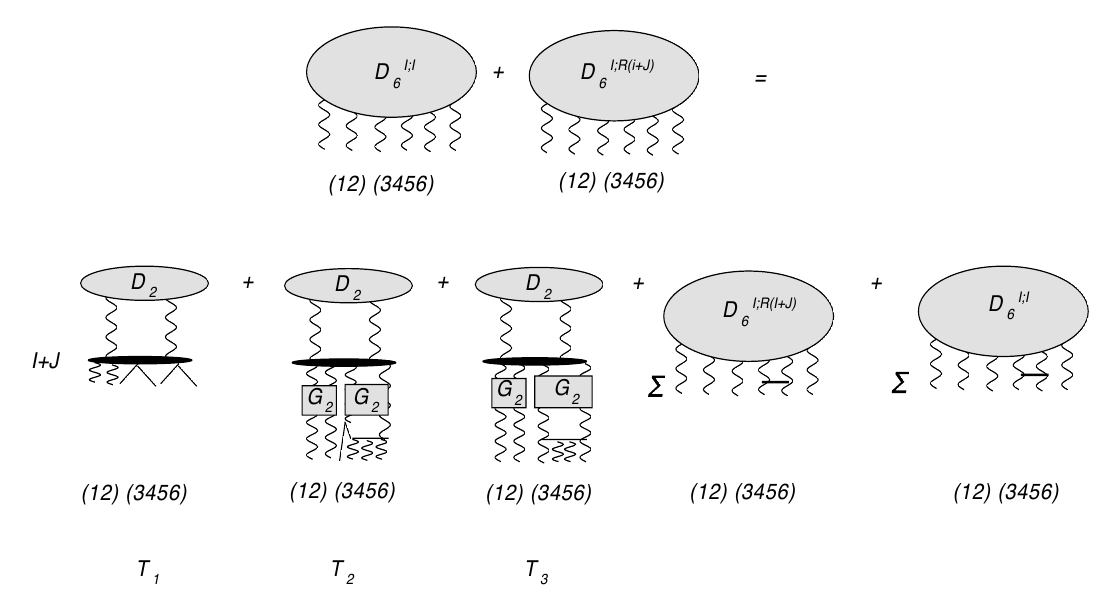
Figure 10 . The integral equation for the combination D I ; R ( I + J ) (12)(3456). Here, in the last two terms, the sum over pairwise interaction includes only the pair (12) and pairwise interactions inside the quartet